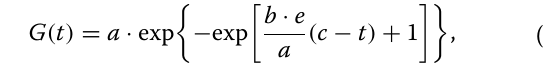
Table 1 Comparison of growth and bioconversion for different initial 1,3‑PDO concentrations in shake flask cultures Initial 1,3‑PDO concentration (g L − 1